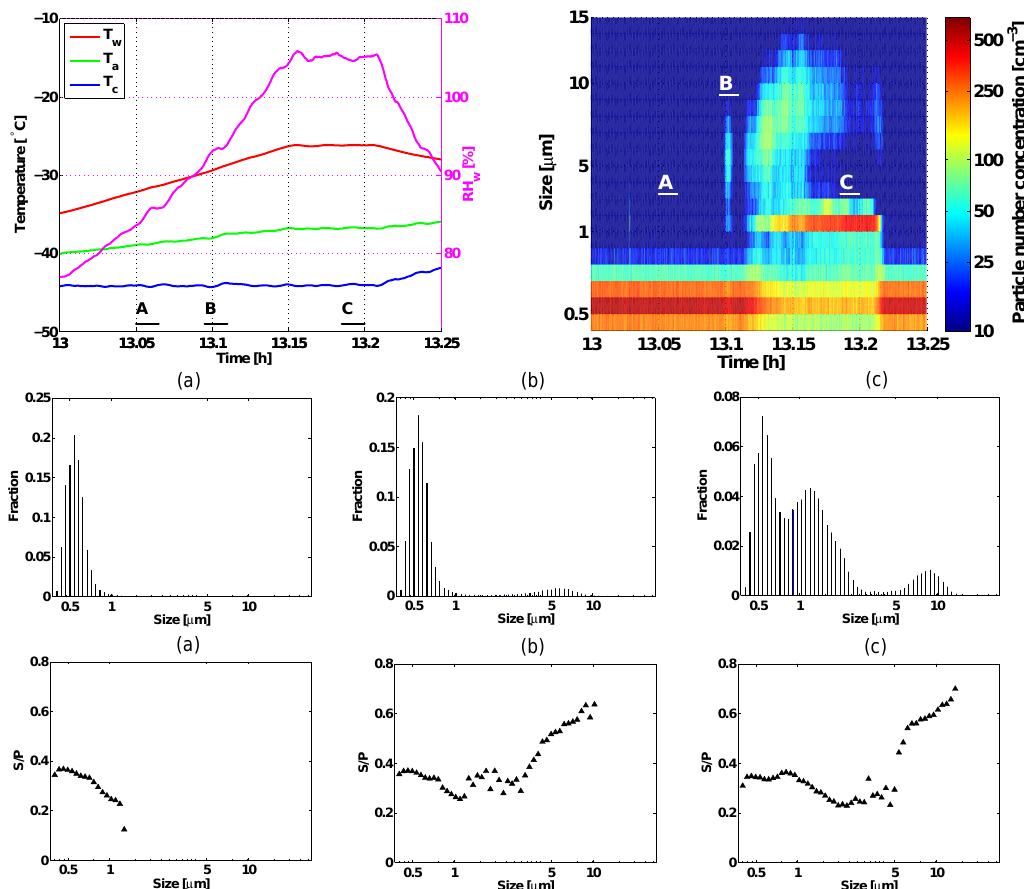
Figure 3. Heterogeneous ice nucleation of viscous α -pinene SOA particles from 26 October 2014. Analogously to Fig. 1, the top left panel shows the SPIN wall and lamina temperatures and the RH w as a function of time, and the top right panel the particle number concentrations in different size bins. Also here, bars A, B, C in the upper panels correspond to the time intervals from which the normalized SPIN OPC particle number size distributions and median values of polarization-equivalent S/P ratios are shown in the lower panels. Panel (a) shows the 550nm seed aerosol and panel (b) depicts seeds and ice crystals at water subsaturated conditions. A prominent (frozen) droplet mode can be seen in panel (c) , when freezing was observed at water supersaturation. The size distributions are averaged over 54s and correspond to the following times in the upper panels: (a) 13.05–13.065h, (b) 13.095–13.11h, (c)